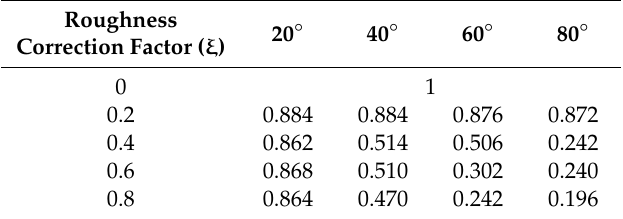
Table 3. The roughness correction factor under di ff erent roughness